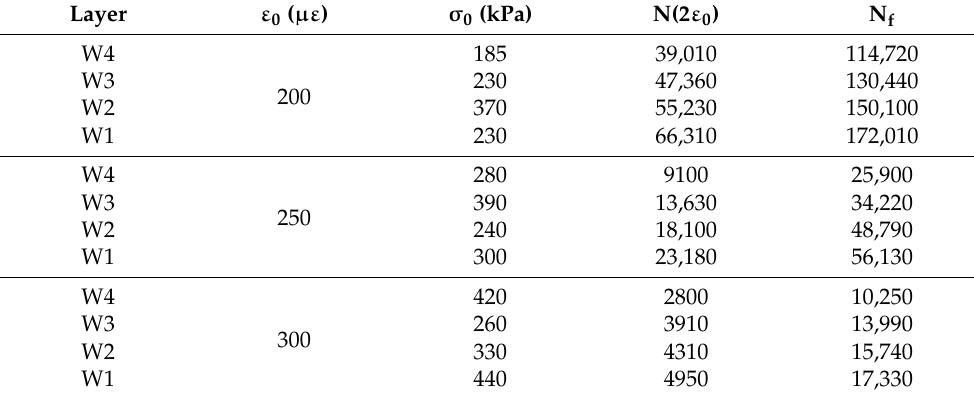
Figure 13. Fatigue curve of binder layers, ε 0 = 200 µε . Tables 7 and 8 list all the average fatigue test results for wearing and binder layers, respectively, where N(2 ε 0 ) is the number of repetitions to double the initial strain and N f is the number of repetitions to have a failure. Table 7. Results of fatigue tests—wearing mixtures.